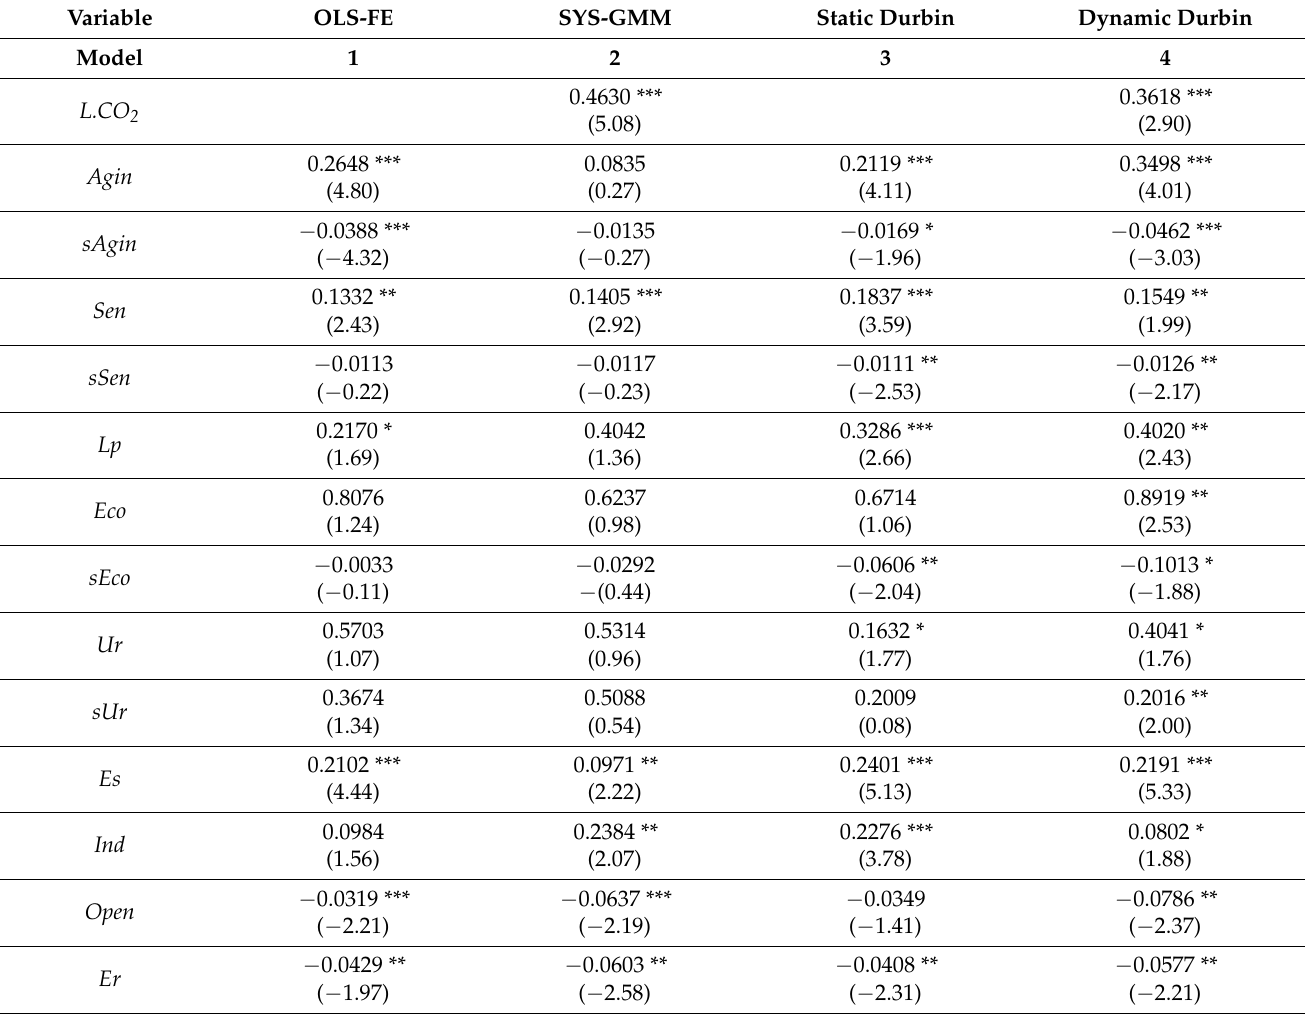
Table 4. Impact of Agin and Sen on carbon emission